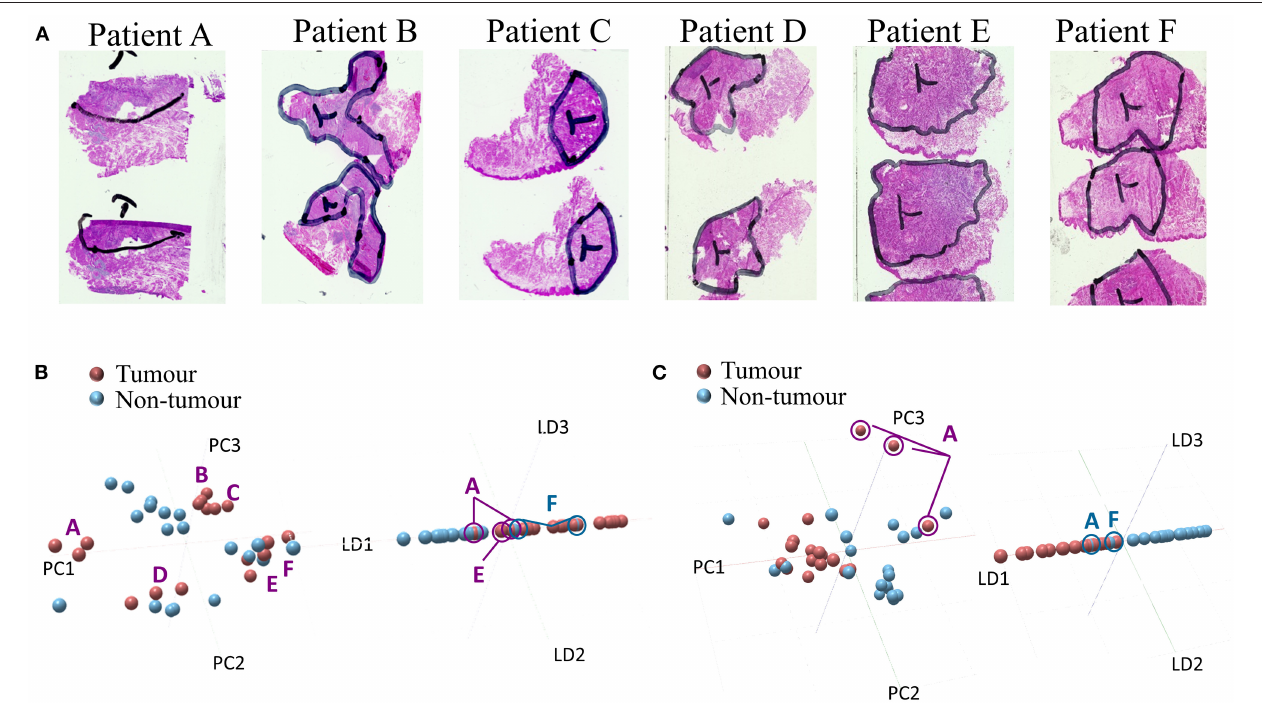
FIGURE 2 | The prospective cohort SpiderMass analysis and classification models. (A) Examples of optical images of histopathological stains and annotations from fresh-frozen squamous cell carcinoma (SCC) samples. The annotations for patients A, B, C, D, E, and F delineate between the tumor and nontumor regions analyzed by the SpiderMass. Random spots were analyzed from each region. The multivariate statistical analysis of mass spectrometry (MS) data from the SCC samples in (B) positive and (C) negative ion mode; tumor (red) and nontumor (blue). PCA plot of 2 tissue types (left) and LDA model representation with a two-class scheme (right). The markers A-F indicate each